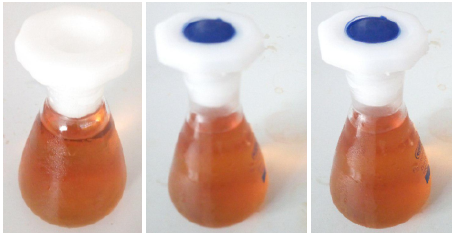
Figure 1: Moringa oleifeira leaves broth solution prepared for this